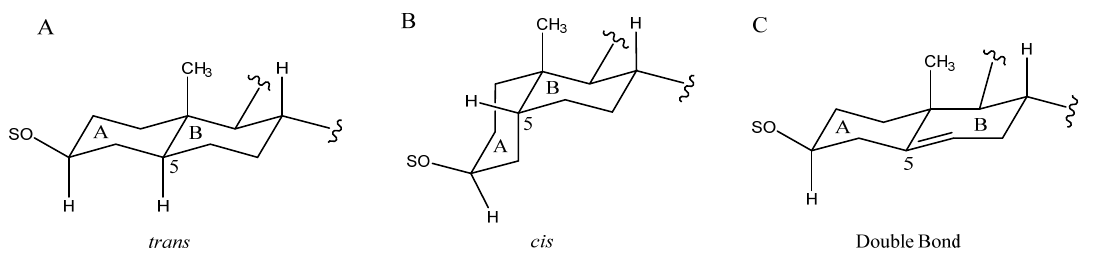
Figure 3. Structure of rings A and B with trans fusion ( A ), cis fusion ( B ) or double bonds between C-5 and C-6 ( C ). The C-22 configuration determines the spirostanic or furostanic nature of a saponin.